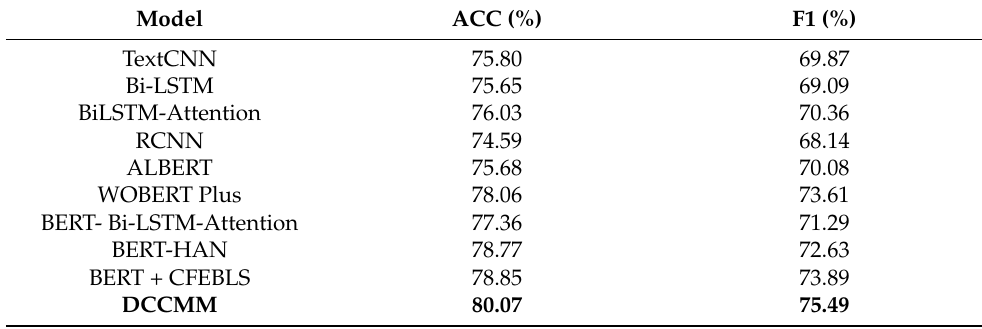
Table 5. Performance comparison of different models on the SMP2020-EWECT